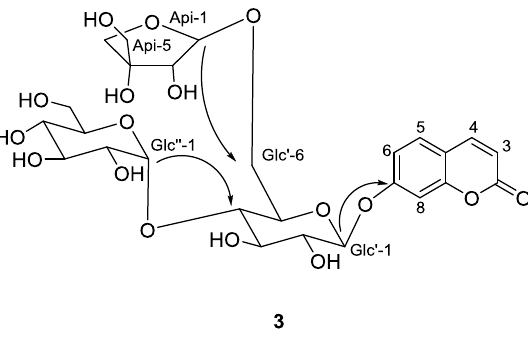
Figure 1. Structures and key HMBCs of compounds 1 – 3 from the stems of Hydrangea paniculata Sieb.